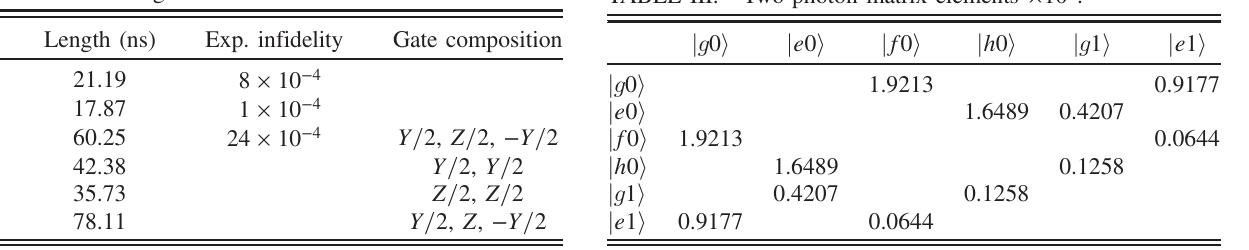
FIG. 6. Simulated expectation values of σ function of pulse parameters Δ t simulation shows extremely good agreement with the experi- mental data as shown in Fig. 4(c).